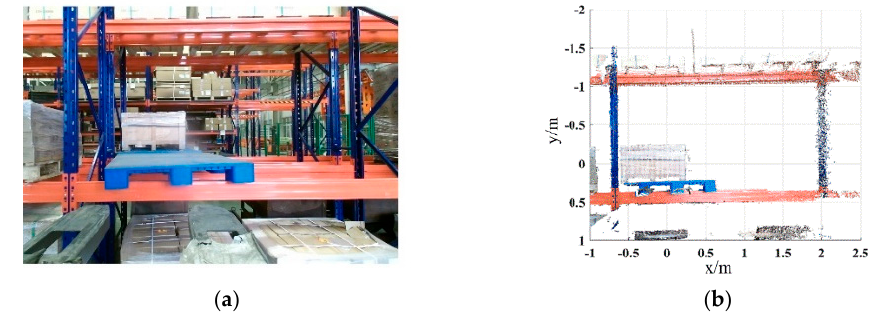
Figure 19. Shelf scene. ( a ) Color image. ( b ) Point cloud.